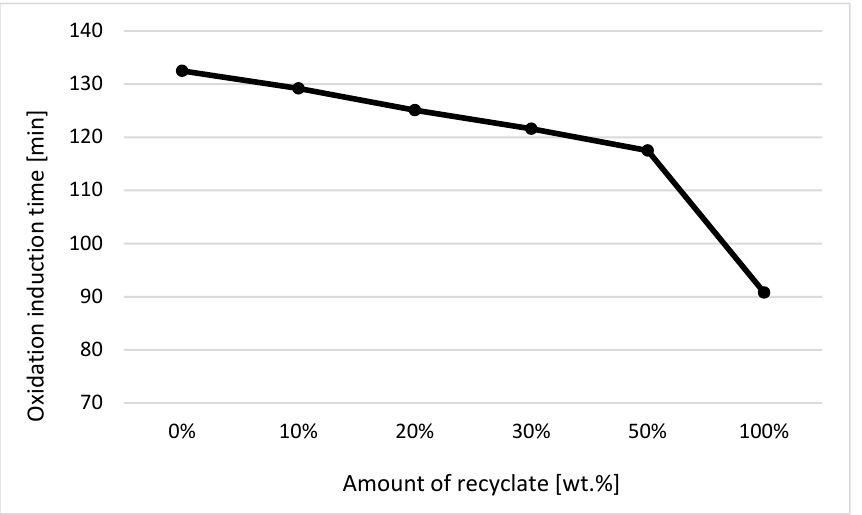
Figure 8. Dependence of the oxidation induction time (OIT) on the proportion of weight of the recycled material before exposure of the samples to elevated temperature.